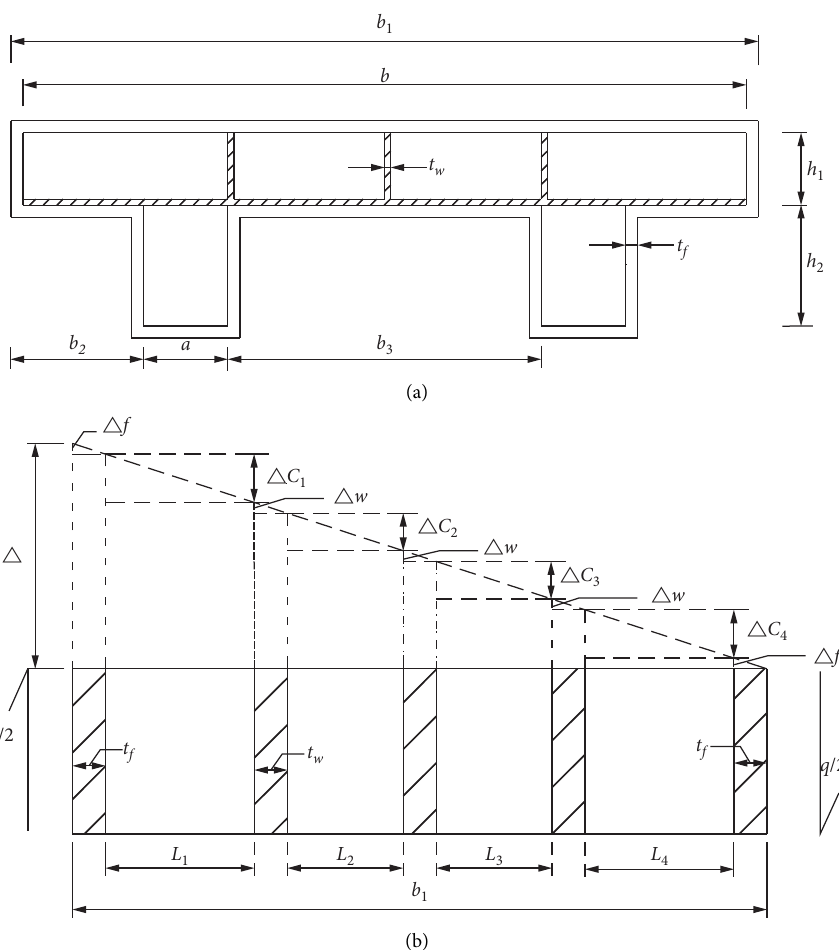
Figure 11: Section of the sandwich deck and the slab configuration under vertical load. (a) Cross section of the deck. (b) Shear deformation of the slab strengthened by